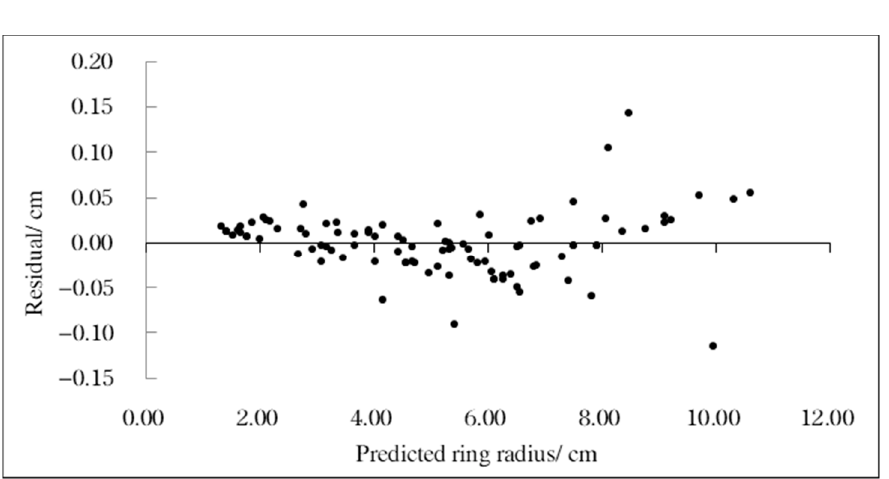
Figure 6. Residual graph of the exponential regression correction model.